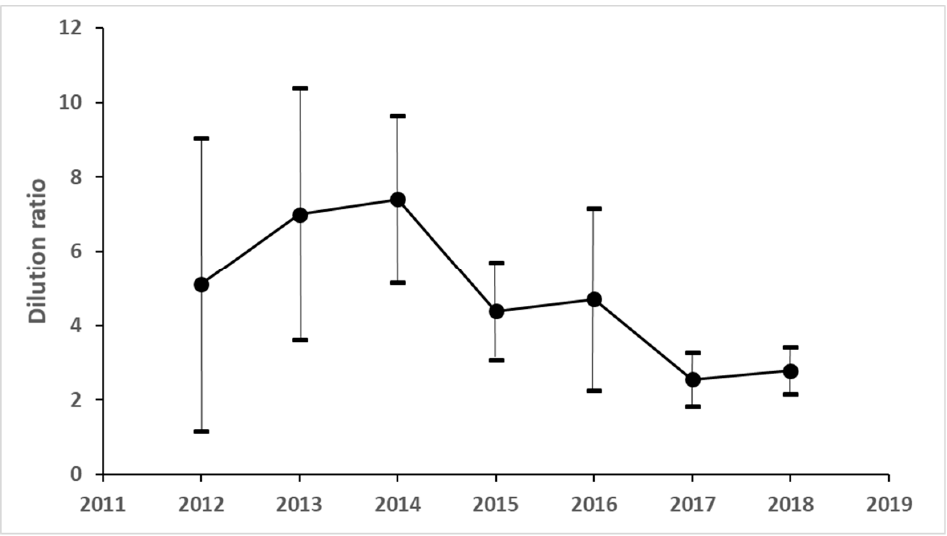
Figure 4. Evolution of the dilution ratio in the studied period. Vertical bars indicate standard deviation.